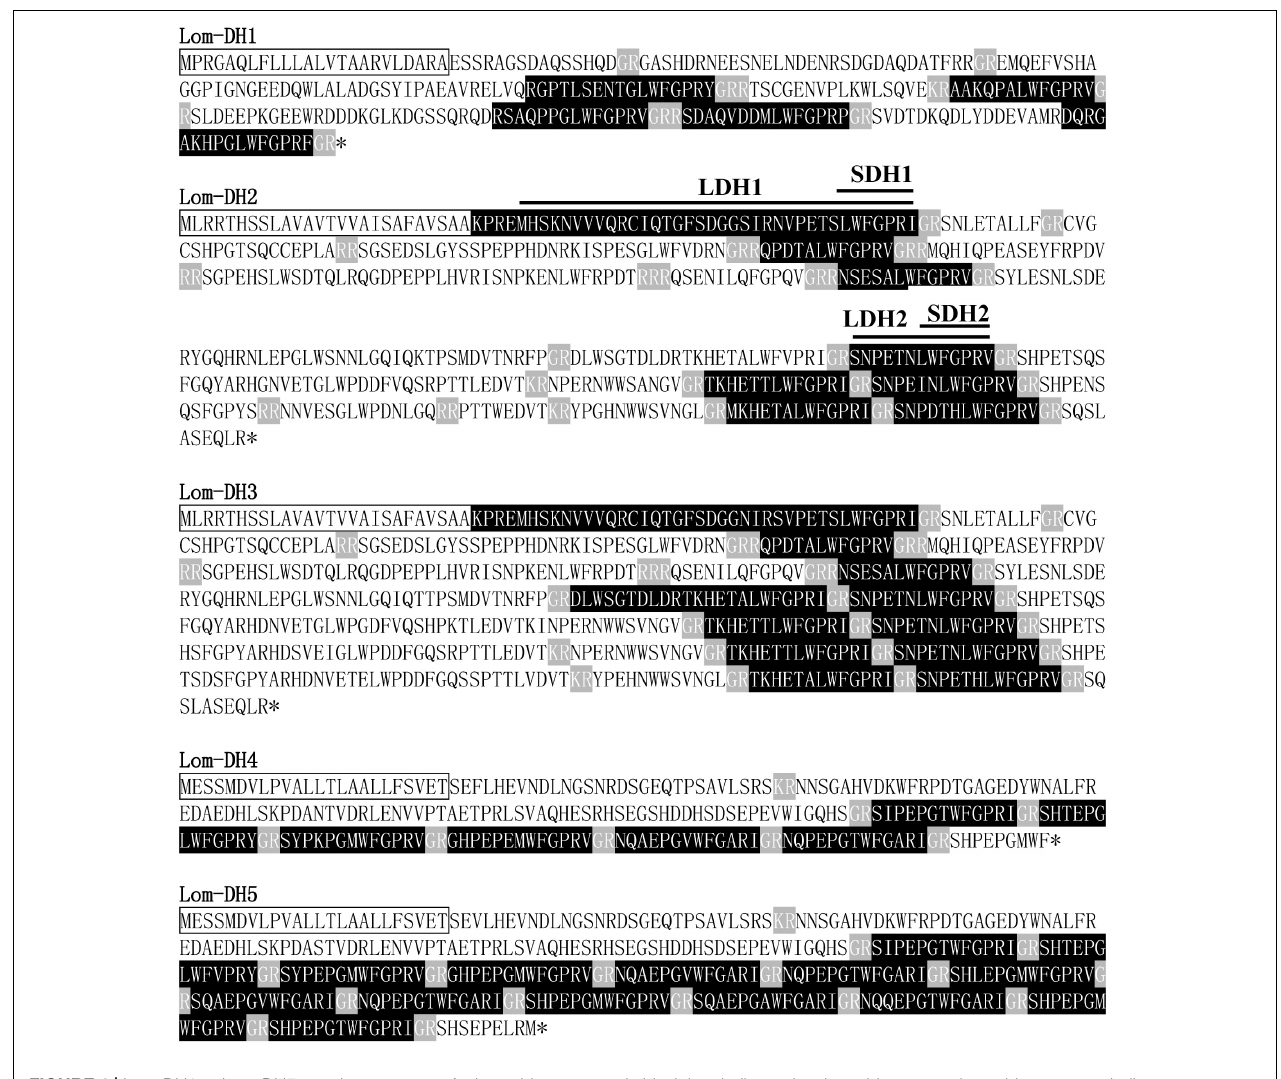
FIGURE 1 | Lom-DH1 to Lom-DH5 protein sequences. Amino acid sequences in black box indicate signal peptide, gray amino acid sequences indicate endoproteolytic cleavage sites, and black amino acid sequences indicate short neuropeptides.